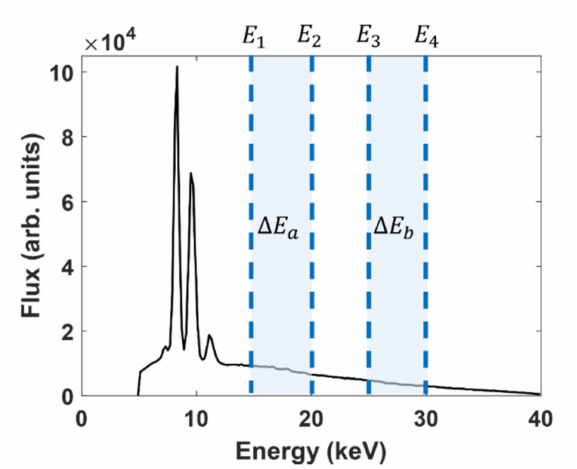
Figure 1. The measured X-ray source spectrum for a tungsten target at a 40 kVp tube voltage, with the four chosen threshold energies E 1 , E 2 , E 3 and E 4 (indicated by dashed vertical blue lines) which together, following image subtraction, create two discrete energy bands shown by the blue shaded areas ( ∆ E a and ∆ E b